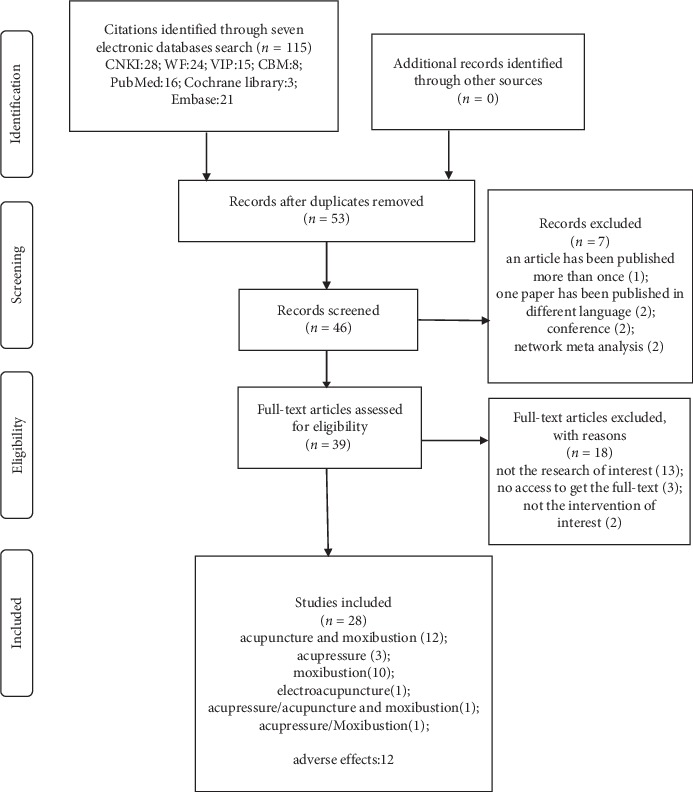
Flowchart of literature selection.